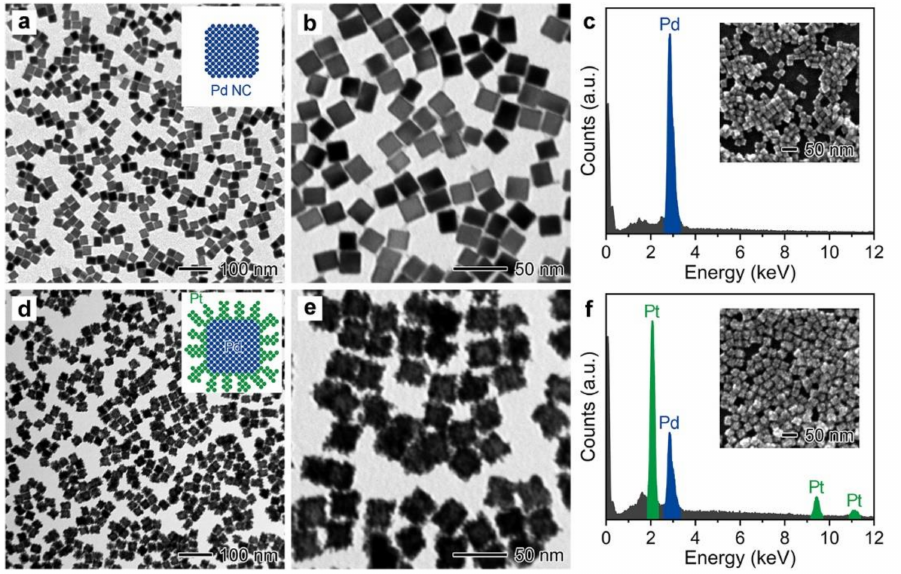
Figure 1. Characterization of 18 nm Pd NCs and Pd@Pt NDs. ( a , b ) Low- ( a ) and high- ( b ) magni- fication TEM images of 18 nm Pd NCs. ( c ) EDX spectrum of 18 nm Pd NCs deposited on a silicon substrate. ( d , e ) Low- ( d ) and high- ( e ) magnification TEM images of Pd@Pt NDs. ( f ) EDX spectrum of Pd@Pt NDs deposited on a silicon substrate. Insets in ( c , f ) show the corresponding scanning electron microscope (SEM) images of the region where the EDX spectra were